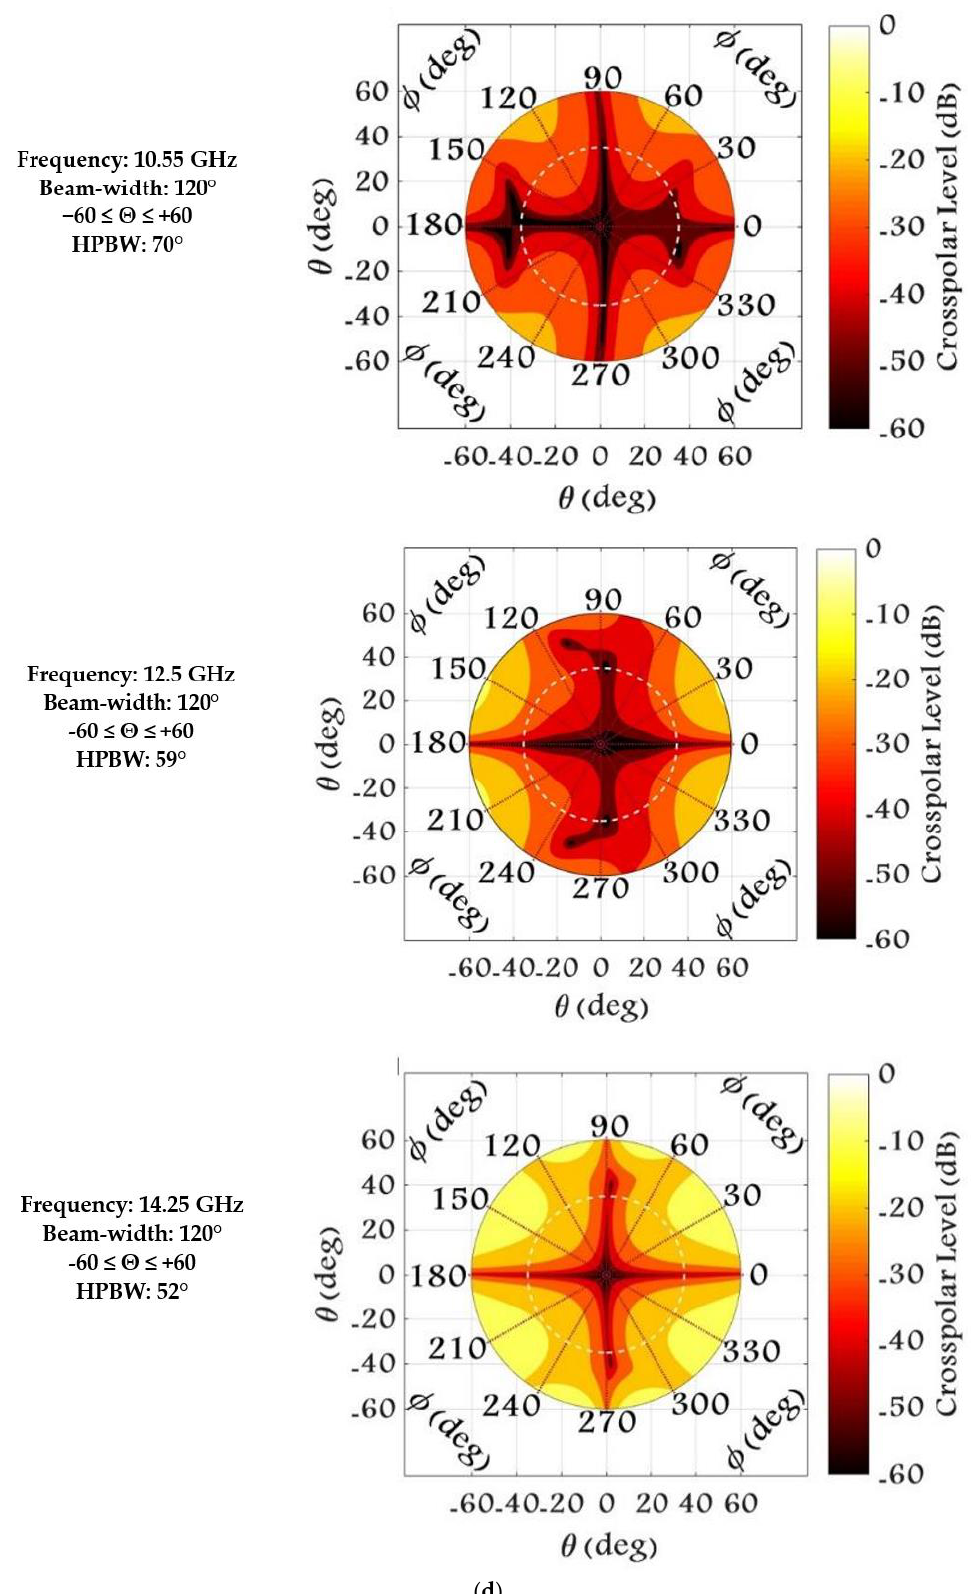
Figure 5. Simulated and measured radiation pattern of the proposed array for different frequencies of ( a ) 10.55, ( b ) 12.5, and ( c ) 14.25 GHz. ( d ) Simulated cross-polarization level of the proposed array versus θ and φ